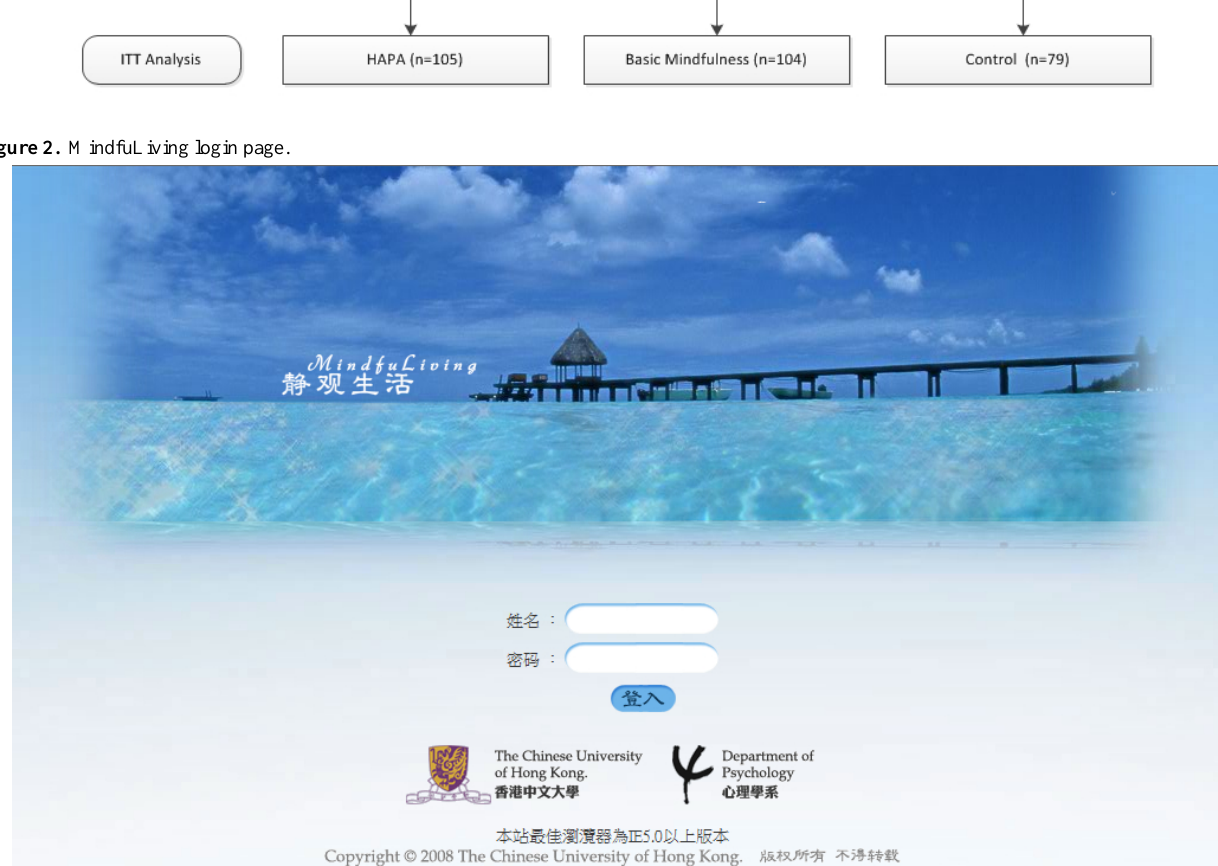
Figure 2. MindfuLiving login